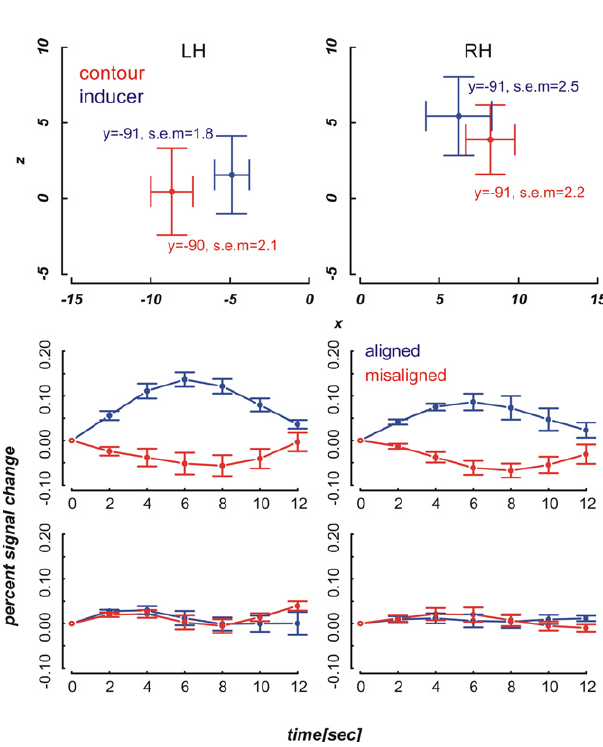
Figure 4. Mean ROI locations and peristimulus plots at ROIs in the far condition. Upper part: Shown are ROI locations of inducers (blue) and con- tours (red) in the left (LH) and right hemisphere (RH) averaged across nine participants. The plots are analogous to a coronal view with the x-axis repre- senting the left-right and the y-axis representing the ventral-dorsal axis. Error bars show the standard error of the mean, the corresponding MNI coordinates in y-direction are written down close to the data points. Lower part: Plots depict the evoked BOLD changes locked to stimulus onset and spanning a time window of 12 seconds. The upper two graphs show the peristimulus plots at the contour ROIs and the lower two graphs those at the inducer ROIs. Left and right columns show the peristimulus plots in the left and right hemi- sphere. Error bars represent the standard error of the mean.